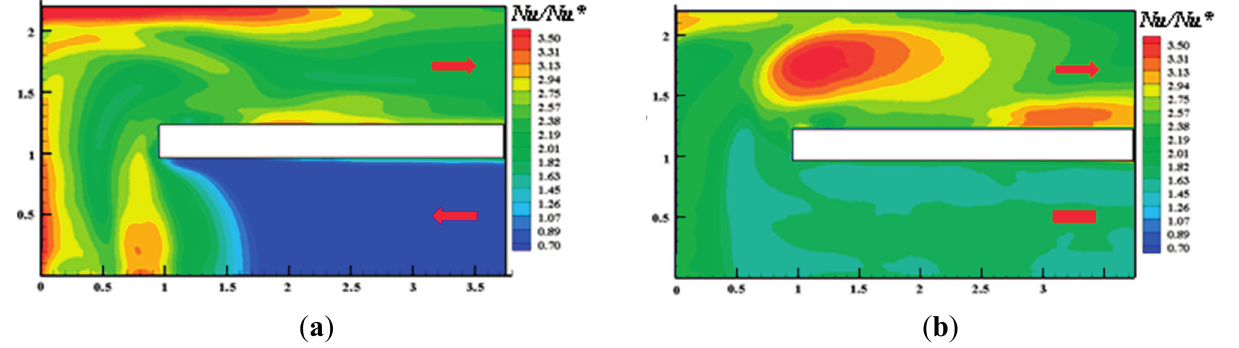
Figure 23. Normalised Nusselt number Nu/Nu* maps for a two-side heated rotating channel; Re = 20,000; Ro = 0.3: ( a ) Leading wall; ( b ) Trailing wall. Flow enters from bottom and exit from top. Adapted from Gallo et al .